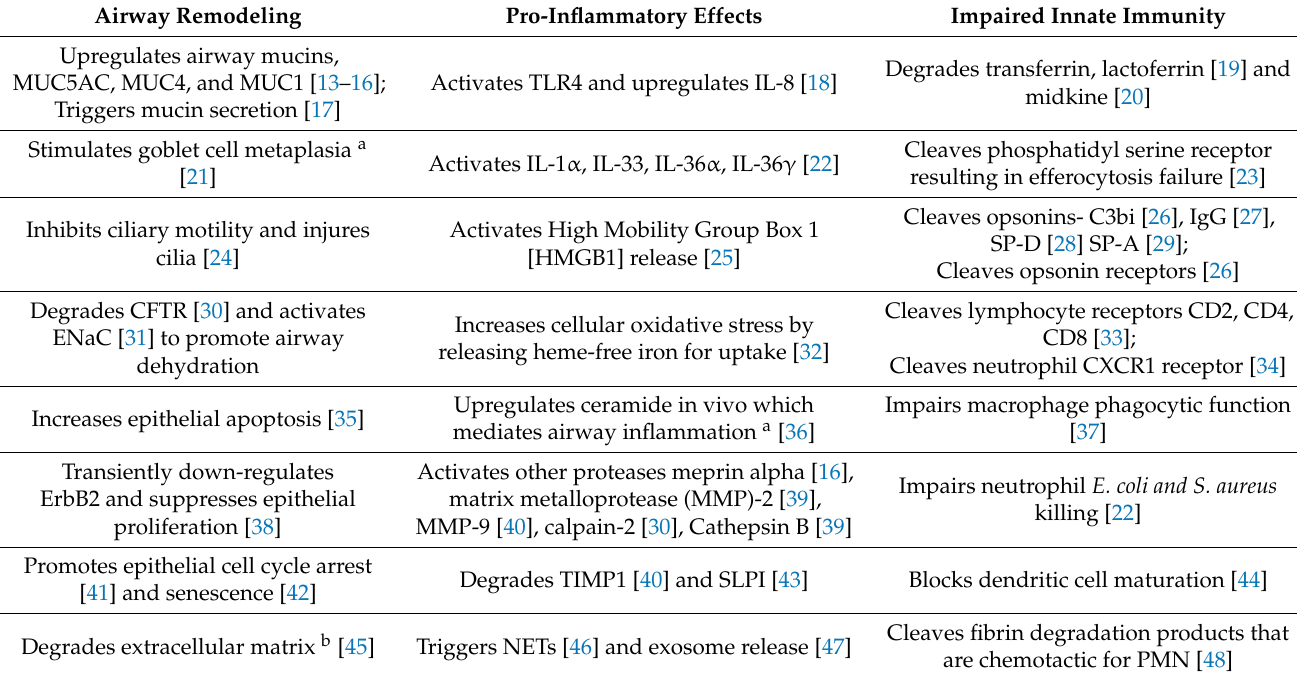
Table 1. Extracellular neutrophil elastase: mechanisms for pathogenesis of chronic lung